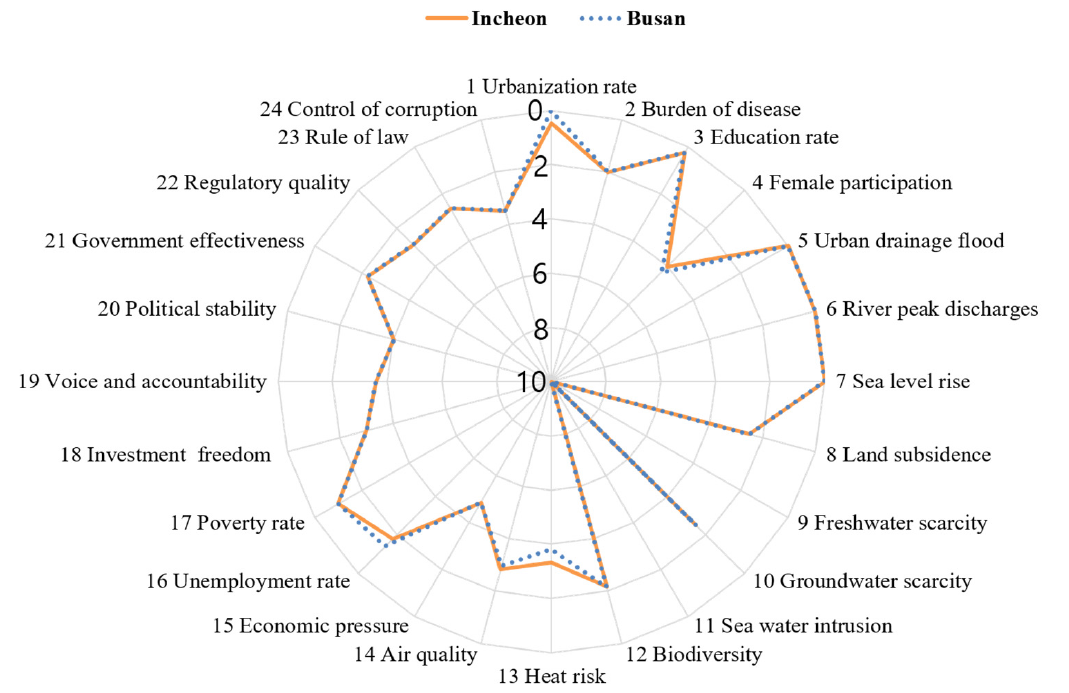
Figure 4. The result of TPF of Incheon (orange) and Busan (blue dot).